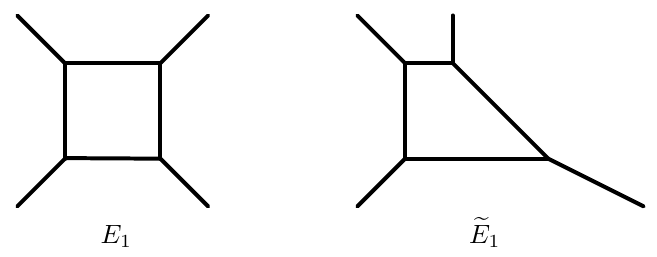
Figure 1. Web diagram for 5d SU(2) theory of enhanced E 1 = SU(2) and